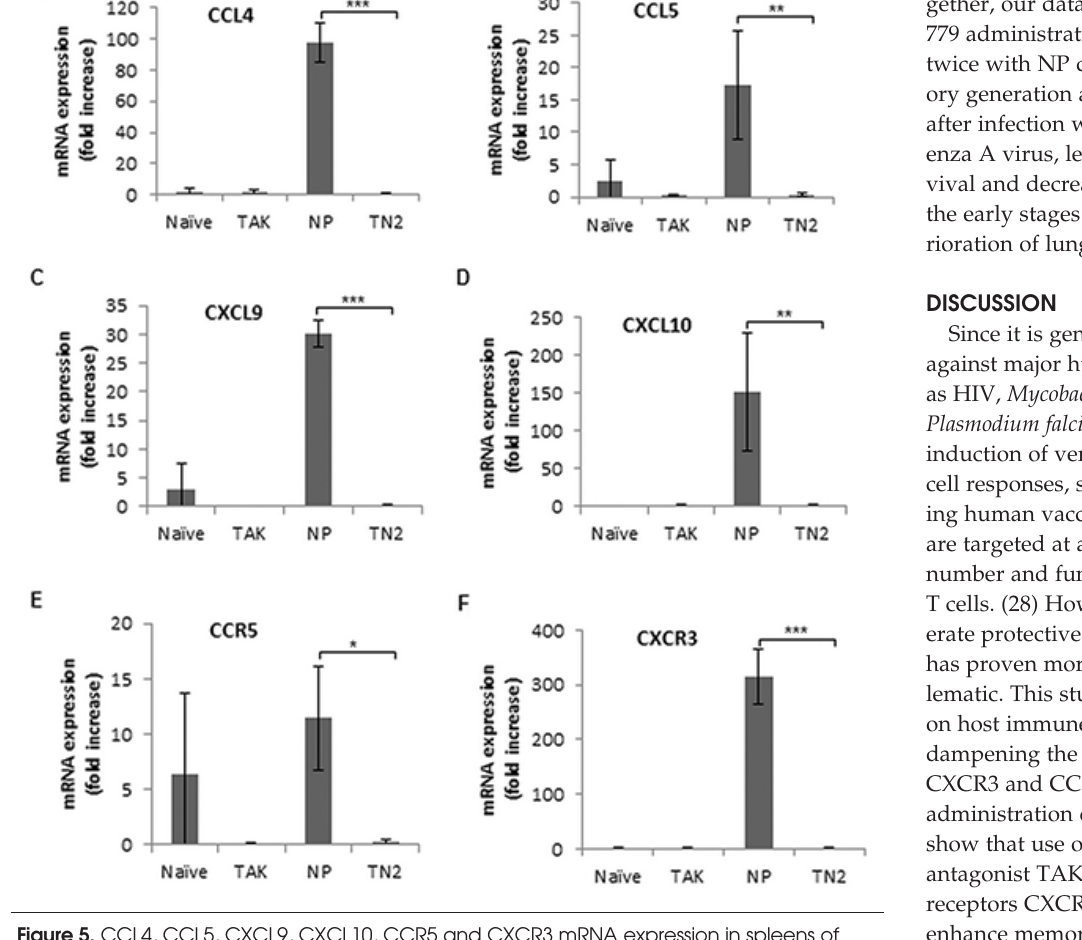
Figure 5. CCL4, CCL5, CXCL9, CXCL10, CCR5 and CXCR3 mRNA expression in spleens of mice immunized twice with NP with or without TAK-779 treatment. Individual spleen pieces from different groups of mice were collected 2 wks after TAK-779 treatment. The mRNA ex- pression of CCL4 (A), CCL5 (B), CXCL9 (C), CXCL10 (D), CCR5 (E) and CXCR3 (F) was mea- sured by quantitative real-time RT-PCR. Results are normalized to β -actin expression. Results are expressed as the mean ± SD. * p ≤ 0.05; ** p ≤ 0.01; *** p ≤ 0.001. The data are represen- tative of 2 independent experiments with 4 mice per group. Mice were analyzed